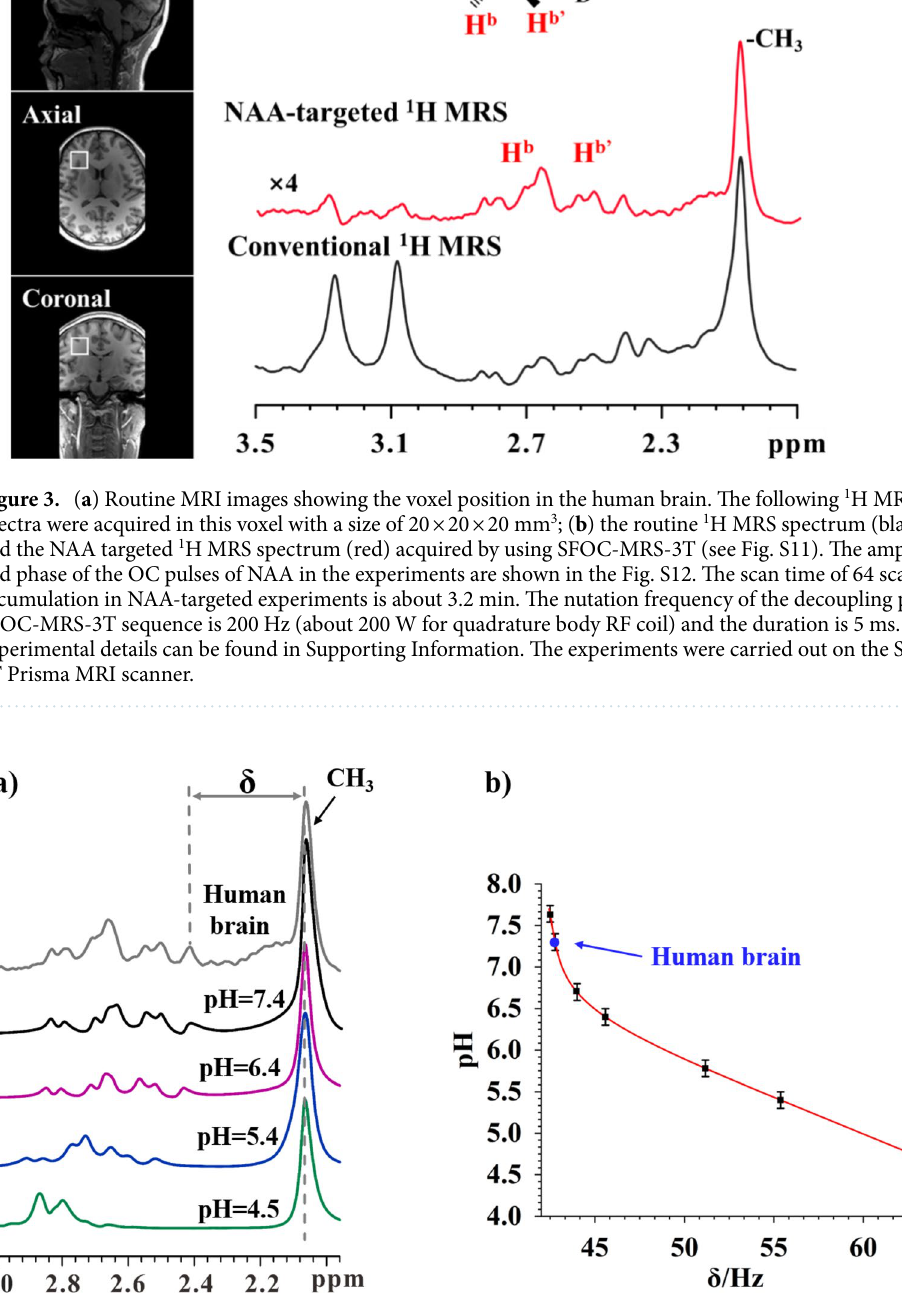
Figure 4. ( a ) The 1 H MRS spectra of NAA aqueous solution containing buffers at the various pH values (black, purple, blue, and green lines) and the NAA-targeted 1 H MRS spectrum of a human brain (the grey line); ( b ) the plot of the frequency difference between the CH 3 signal and the first peak of H b’ signals of NAA (see a ), δ, as a function of the pH values. The full width at half maximum (FWHM) of NAA signals in NAA-targeted spectrum is approximately 3 Hz. The error margin of the pH measurement using SFOC-MRS-3T sequence is ~ 0.1 when the frequency uncertainty of the NAA signals is 0.5 Hz (up